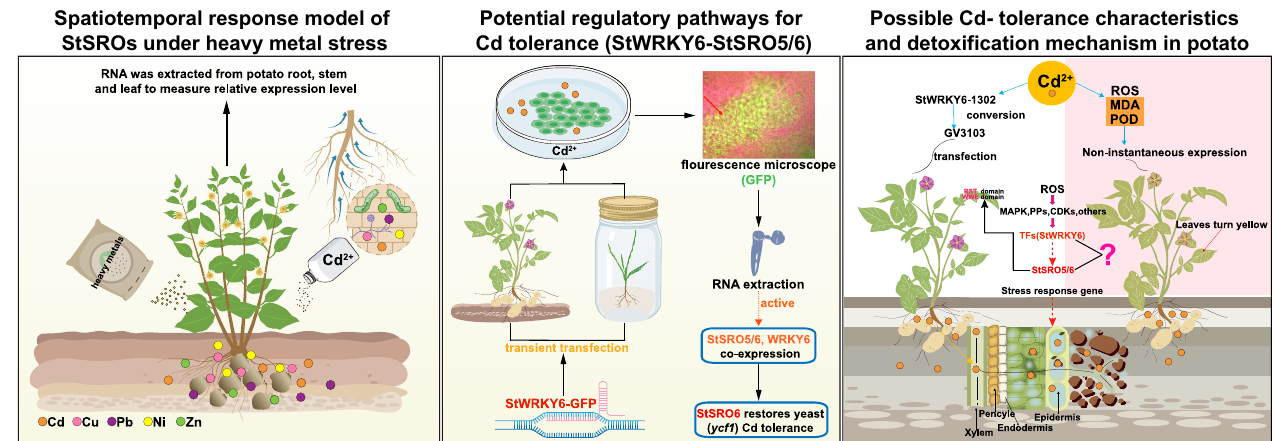
Figure 8. Test design, methods, and conclusions of StSROs identification and functional verification under Cd stress response.